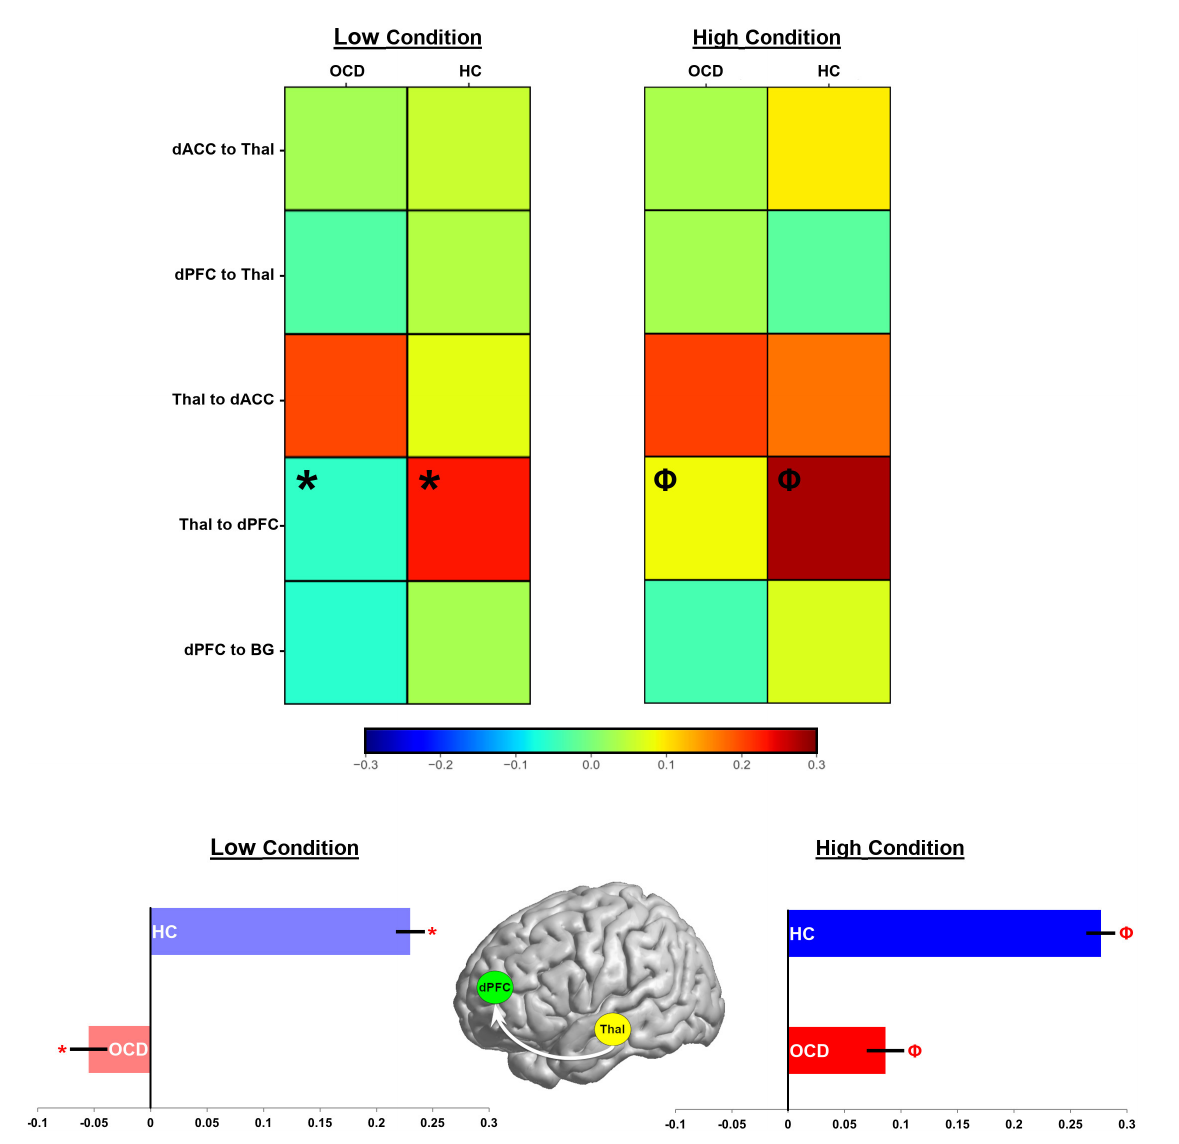
FIGURE7 Parameter estimates for the contextual modulation of network pathways are present in heat maps (see color bar for values). Values for the low demand condition are on the left, while those for the high demand condition are on the right. In each map, groups are presented in separate columns (OCD, HC). Independent samples t -tests revealed statistically significant differences between OCD and HC in the Thal → dPFC pathway for both task conditions (Low demand: *; High Demand: (cid:56) ). These data are depicted in bar graphs below to accentuate the effect ( ±